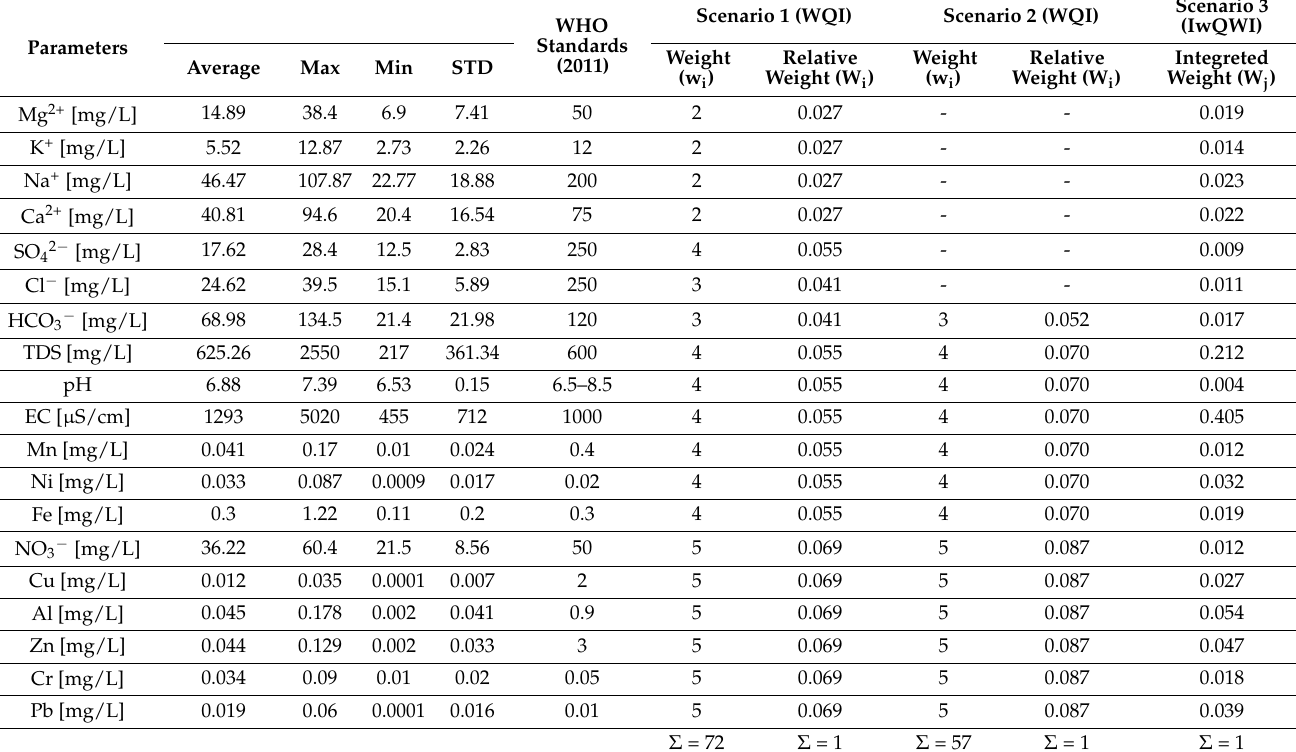
Table 2. Descriptive statistics and WQI parameters for groundwater